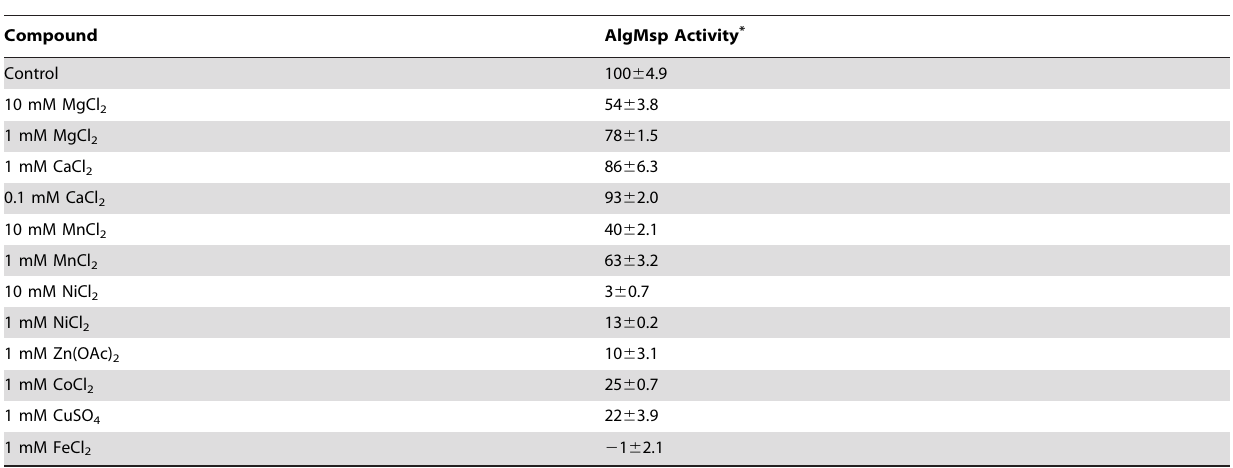
Table 1. Effects of divalent cations on AlgMsp activity.